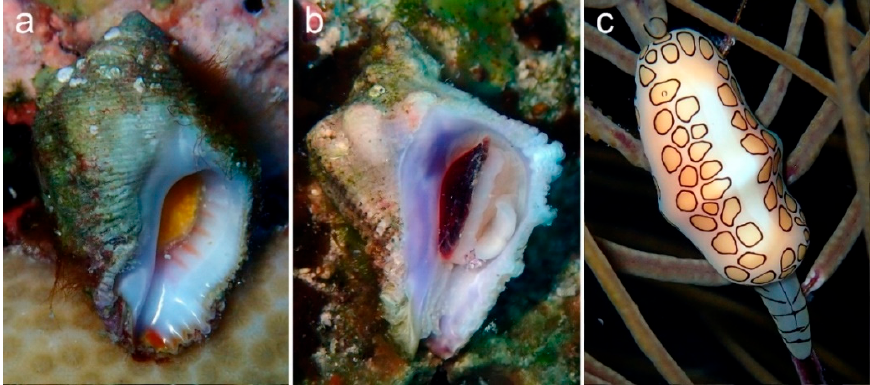
Figure 1. The three corallivorous snails encountered on Bonaire: ( a ) Coralliophila galea ; ( b ) Corallioph- ila salebrosa ; ( c ) Cyphoma gibbosum. ( c ) Cyphoma gibbosum